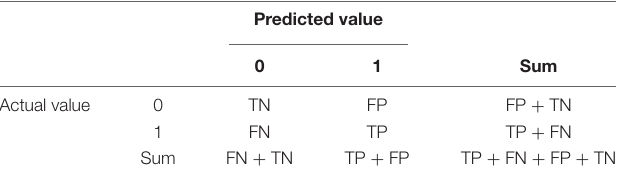
TABLE 1 | Confusion